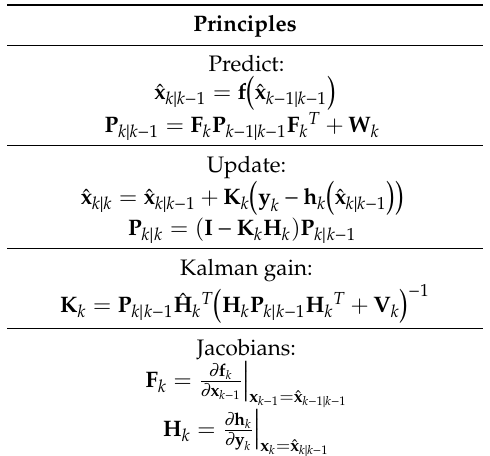
Table 1. Kalman Filter.